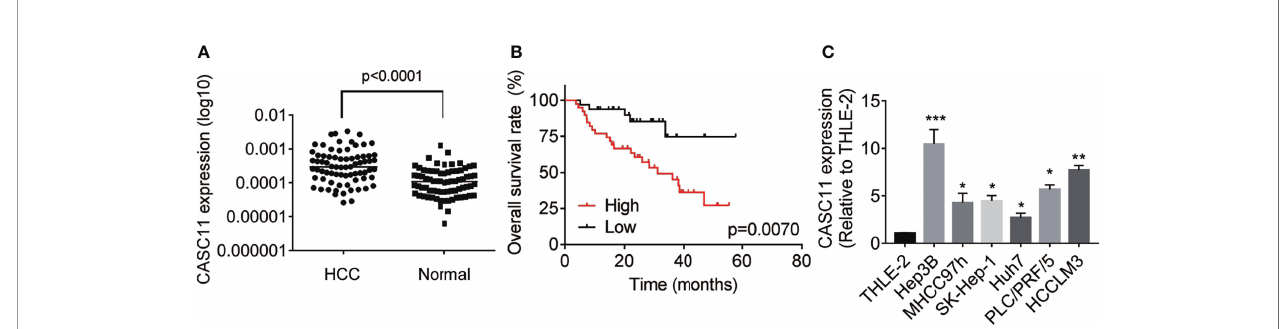
FIGURE 1 | Overexpression of CASC11 indicates poor prognosis in HCC patients. (A) qRT-PCR assay was applied to detect the CASC11 expression in 72 pairs of HCC and matched normal liver tissues (Wilcoxon matched-pairs signed rank test). Line indicated the median value of CASC11 expression. (B) The patients were divided into CASC11-high and CASC11-low group based on the median value of CASC11 expression in HCC tissues. Kaplan-Meier method and log-rank test was used to evaluate the relationship between CASC11 expression and prognosis of patients with HCC. (C) The expression levels of CASC11 between HCC cell lines and human normal hepatocyte THLE-2 cells were tested using qRT-PCR assay. *p < 0.05. Data are mean ± SD. *p < 0.05, **p < 0.01, ***p